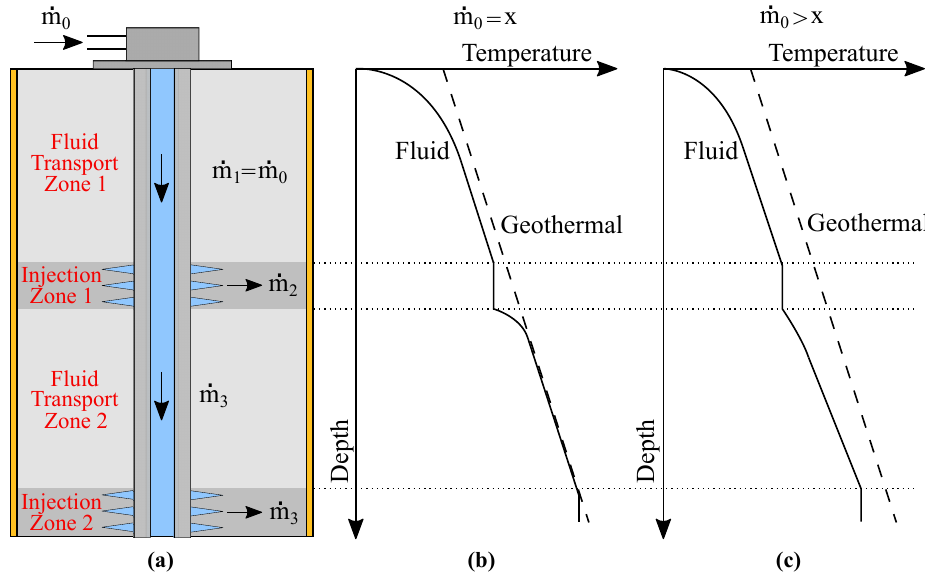
Figure 1. Flow and temperature along a multiple-zone water-injection well used as reference for the completion structure. ( a ) Longitudinal section and the flow distribution in the injection intervals. ( b ) Hypothetical fluid profile for ˙ m 0 = x as the consequence of the influence of the hypothetical geologic-formation profile. ( c ) Hypothetical fluid profile for ˙ m 0 > x